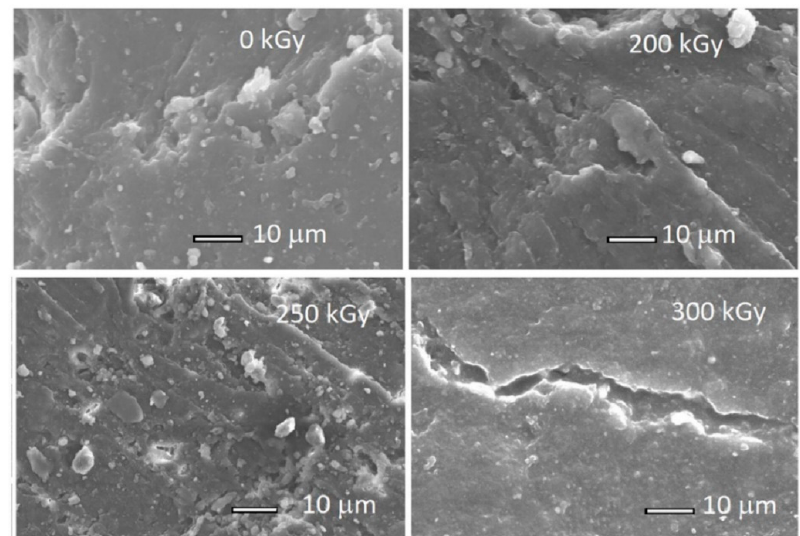
Figure 9. SEM images of untreated and irradiated (different energy levels) waste tire rubber particles (amplification 1500×) (reproduced with permission from [64]).